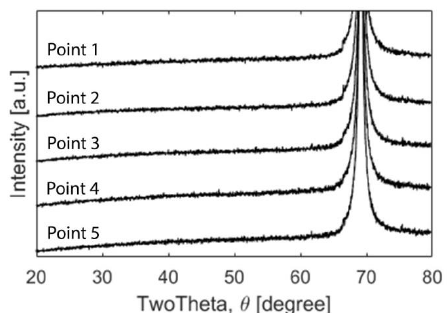
Figure 4. XRD diffractograms for points 1 – 5. The only detectable peak was the Si (400) at 69°.